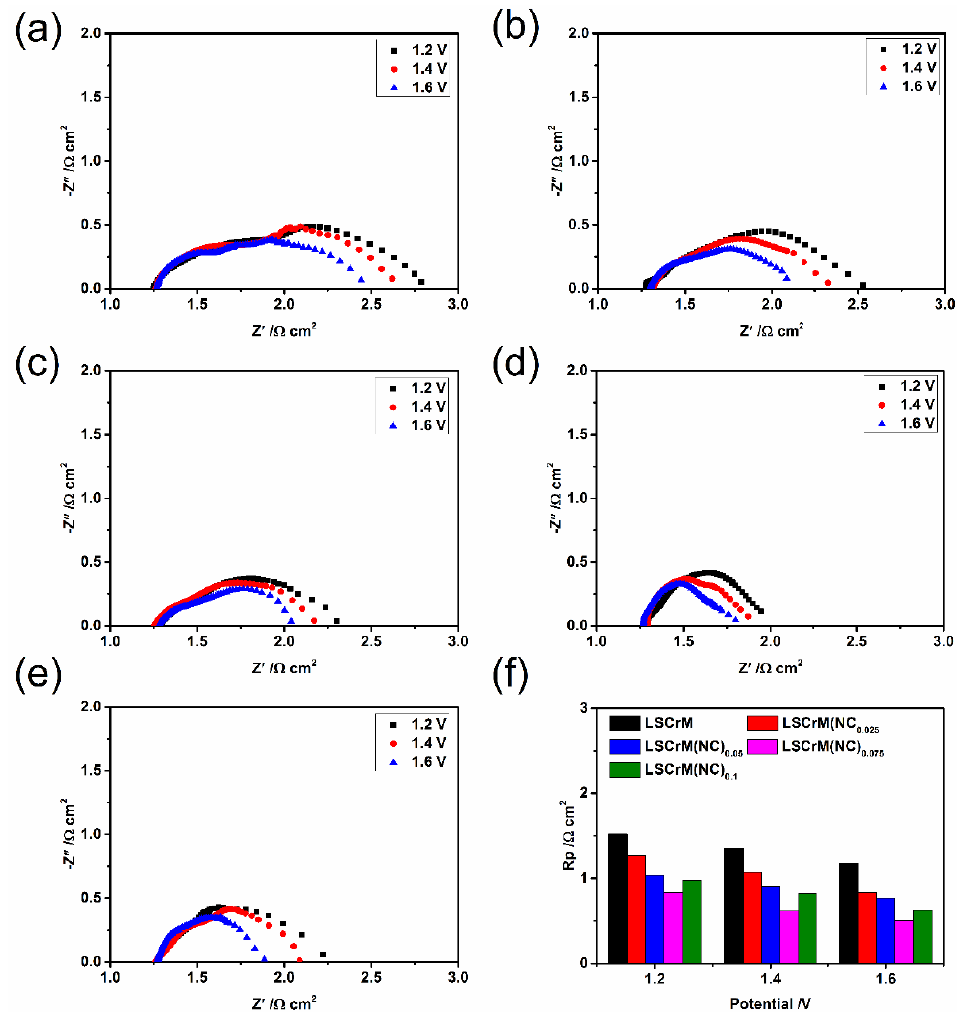
Figure 6. Impedance spectra of LSCrM(NC) x at different voltages. ( a ) LSCrM, ( b ) LSCrM(NC) 0.025 , ( c ) LSCrM(NC) 0.05 , ( d ) LSCrM(NC) 0.075 , ( e ) LSCrM(NC) 0.01 , and ( f ) the corresponding polarised resistance of LSCrM(NC) x .